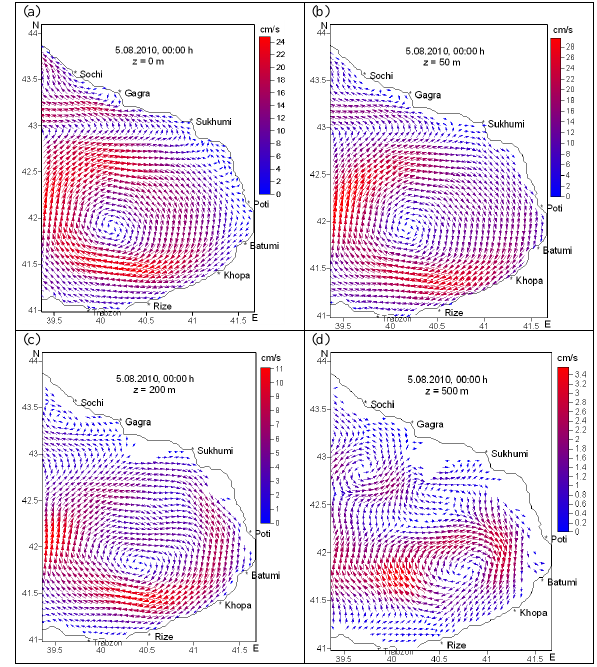
Fig. 2. Current field at 5.08.2010, 00:00 h on depths of 0 m (a), 50 m (b), 200 m (c), and 500 m (d).